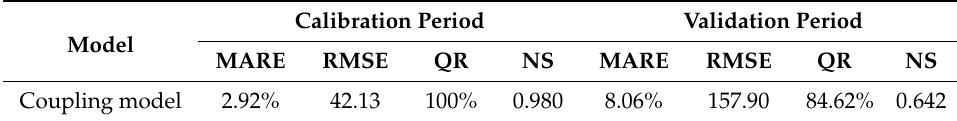
Table 6. Evaluation indexes of the coupling model.